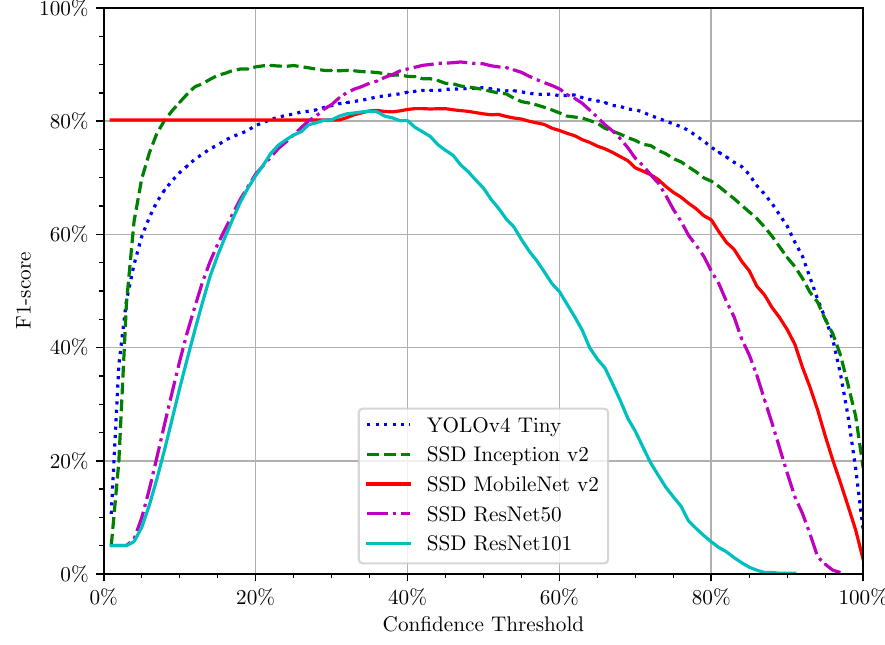
Figure 9. Evolution of the F1-score with the variation of the confidence threshold for all DL models in the validation set without